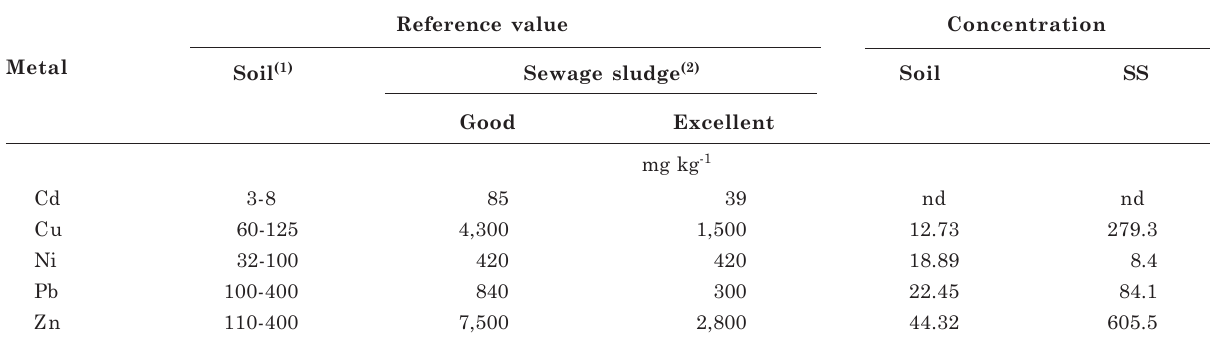
Table 1. Concentration of heavy metals in soil, sewage sludge and maximum permitted